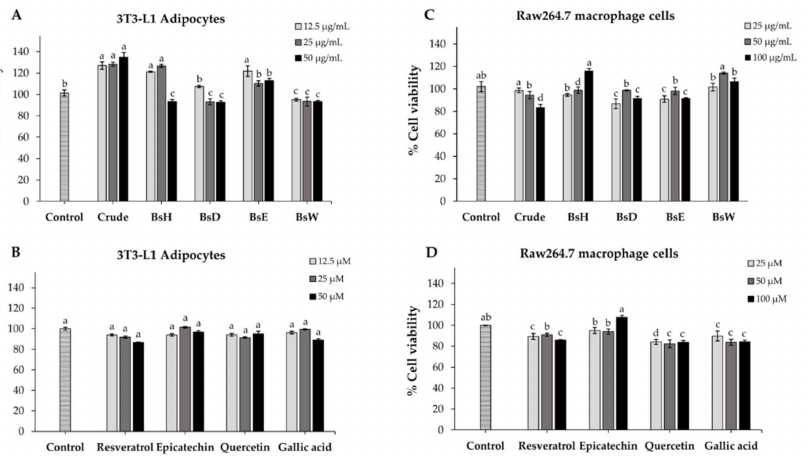
Figure 3. The percentage of cell viability of 3T3-L1 adipocytes ( A , B ) and raw264.7 macrophage cells ( C , D ) after treatment with different concentrations of crude extract, partitioned fractions, and isolated compounds. Values are expressed as the means ± SD ( n = 3). Different letters (a–d) indicate statistical difference ( p <